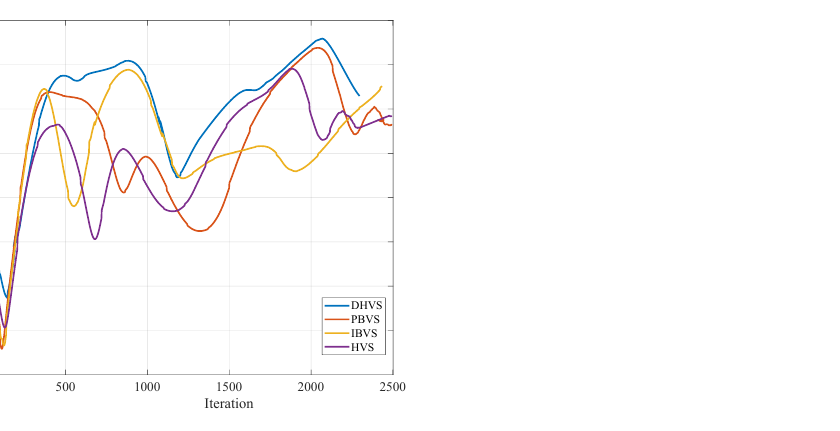
Figure 8. Analysing the manipulability of different VS methods during tracking the trajectory (introduced in Case study 3) of a dynamic object.